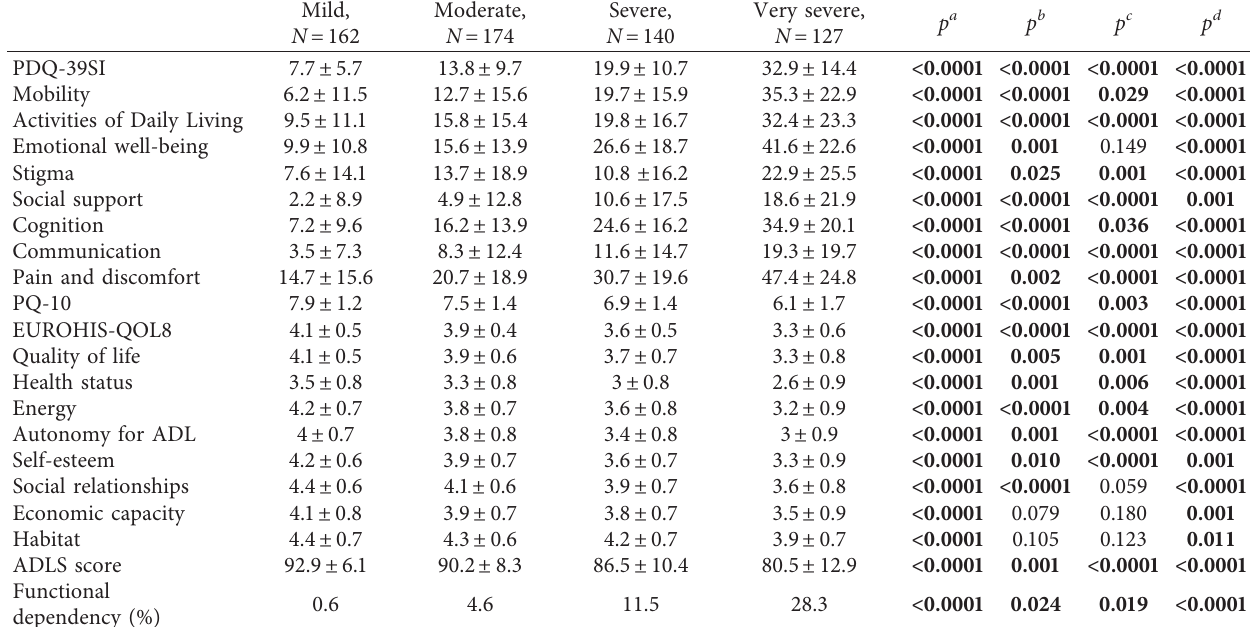
Figure 2: PDQ-39SI and EUROHIS-QOL8 scores in patients with regard to the H&Y (a), the nonmotor symptoms burden (NMSB) (b), and both (HY.NMSB) (c) ( n � Table 2: Quality of life (PDQ-39SI and EUROHIS-QOL8) and disability (ADLS score) in PD patients with regard to nonmotor symptoms burden: mild (NMS 1-20); moderate (NMS total score 21-40); severe (NMS total score 41-70); very severe (NMS total score > 70).